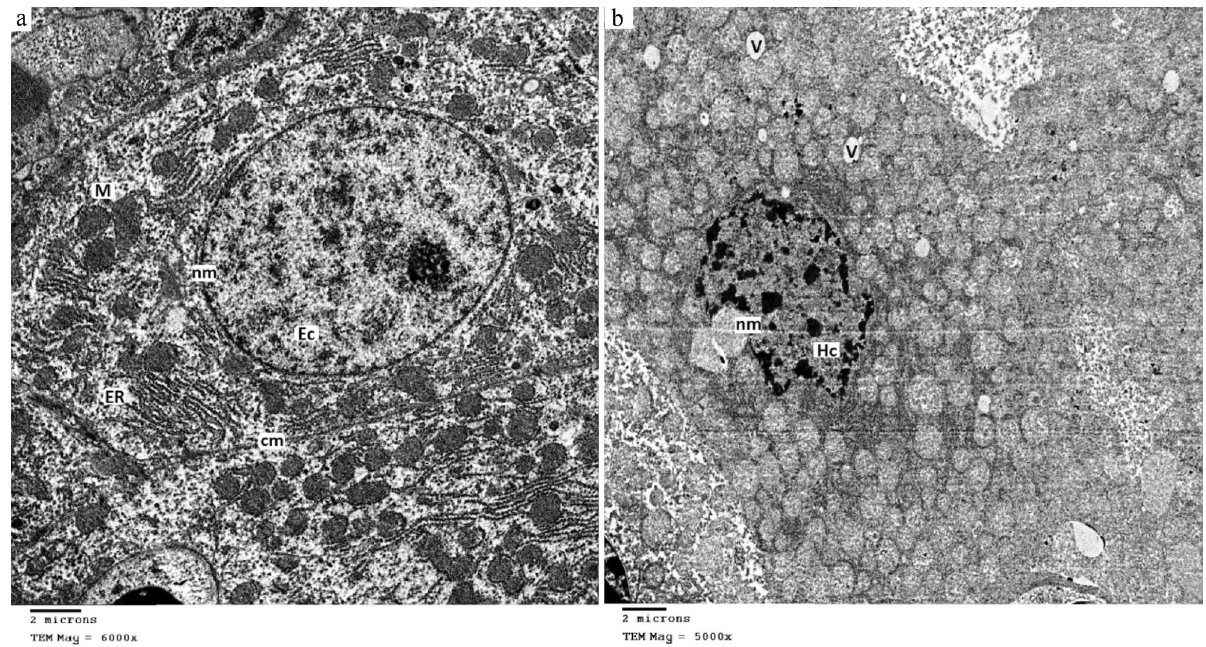
Figure 5. TEM micrographs showing the ultrastructural changes in the hepatocytes of treated and control mice. ( a ) A typical hepatocyte shows an intact cell membrane (cm) and intact nuclear membrane (nm) containing euchromatin (Ec). Also, it shows an intact rough endoplasmic reticulum (ER) and extensive normal mitochondria (M). ( b ) A liver cell of a mouse that has received an active preparation of UcB5 protease. It shows vesiculation (V) and malformed nuclear membrane (nm) with heterochromatin (Hc). It shows the disappearance of the cell membrane and rough endoplasmic reticulum. The in vivo cell damaging activity was evaluated by experimenting with the BALB/c mice housed in six groups. Briefly, a purified UcB5 in a total of 1 ml volume was inoculated in every mouse by the intraperitoneal route. Every mouse was inoculated with a heat-inactivated enzyme preparation for the universal control group. Livers were removed from the sacrificed and the control animals and fixed. Finally, ultrathin sections of 70 nm thickness were taken with RMC ultramicrotome and supported on copper grids for electron microscopic examination under JEOL 1010